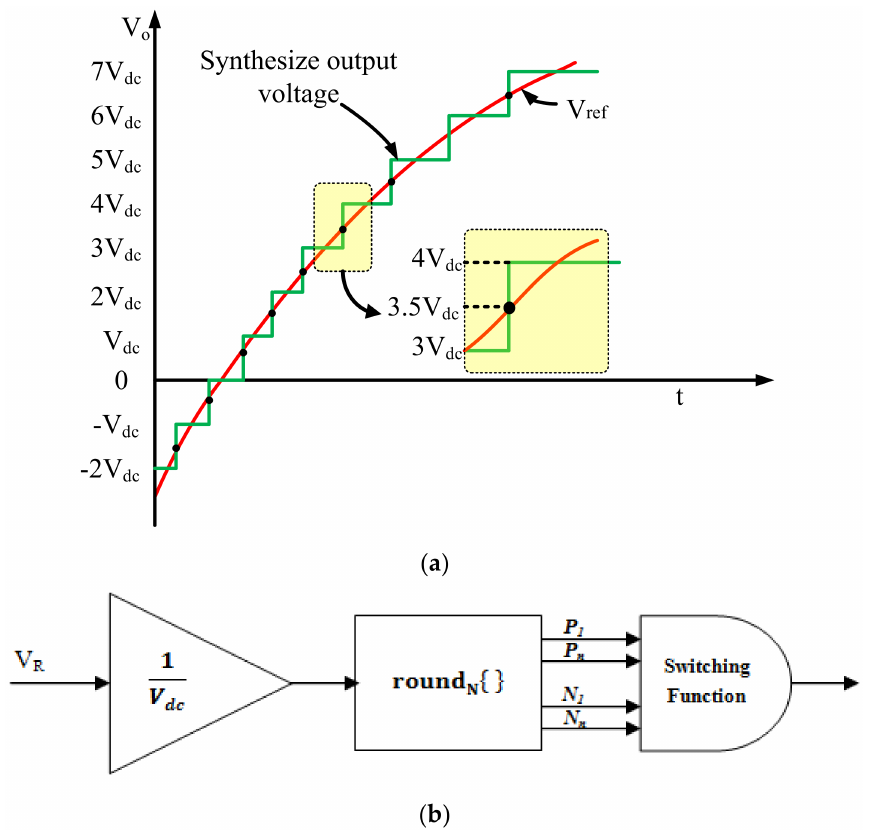
Figure 4. NLCPWM with ( a ) Synthesizing the Terminal Voltage from Reference ( b ) Switching Function of NLM